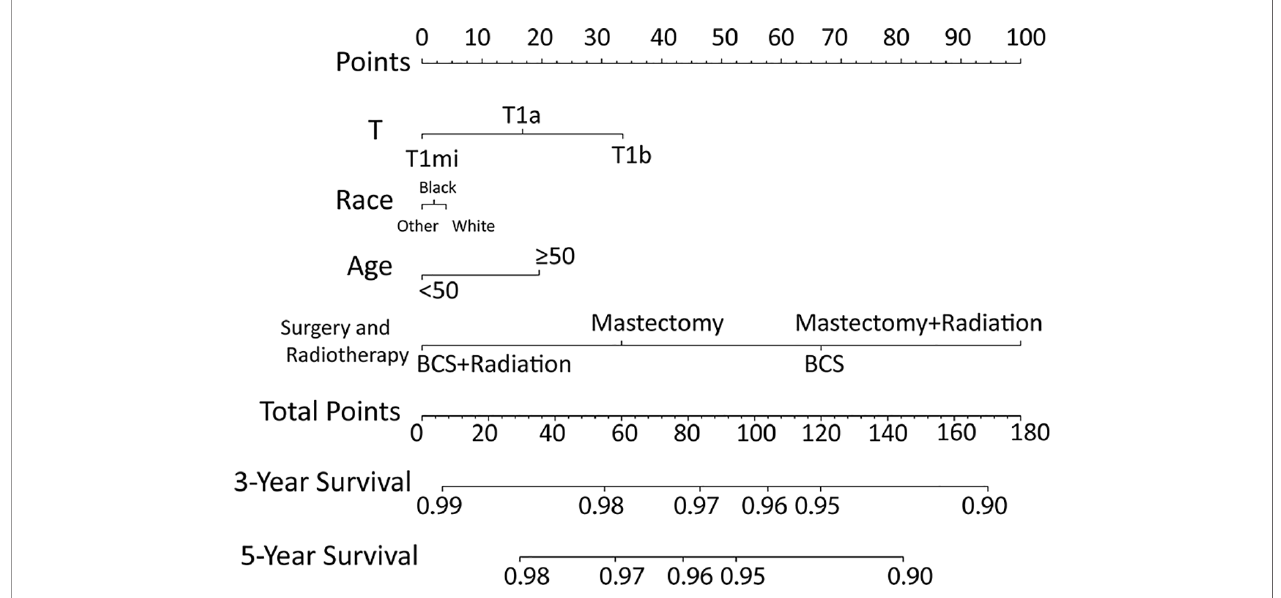
FIGURE 4 | Nomogram for predicting 3 ‐ and 5 ‐ year overall survival among node-negative triple-negative breast cancer patients with tumor size less than 1